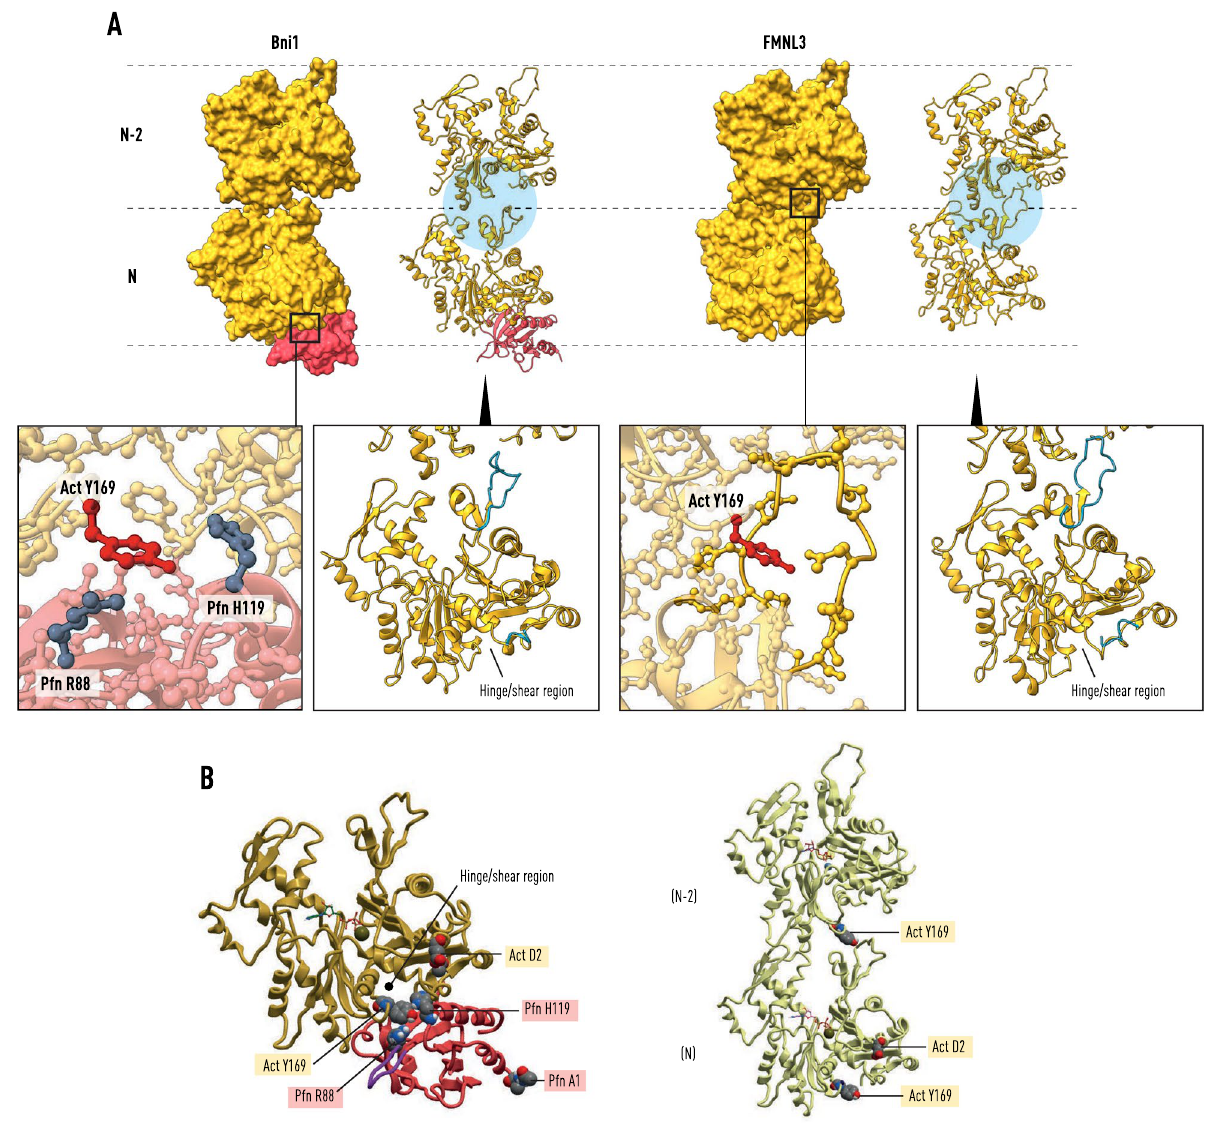
Figure 3. Profilin release associated with polymerization. Panel ( A ) shows actin(N)-actin(N−2) as bound by the Bni1 and FMNL3 FH2 dimers, (left) and (right), respectively. In Bni1, the actin molecules are coplanar, while in FMNL3 they are related by the helical symmetry of the cryo-EM structure (PDB: 6DJO). During the release of profilin from actin(N) in the Bni1 structure the D-loop in SD2 extends towards actin(N−2) as seen in the FMNL3 structure. Y169, the central residue in the longitudinal contact between actin(N) and actin(N−2), is exposed with the release of profilin. Panel ( B ) depicts the profilin-β-actin structure (PDB: 2BTF) showing the proximity of the profilin binding site to the hinge and shear region of actin. The FH2 knob helix A occupies part of this site with profilin (not shown). The right image illustrates the environment of Y169 in the longitudinal bond of the